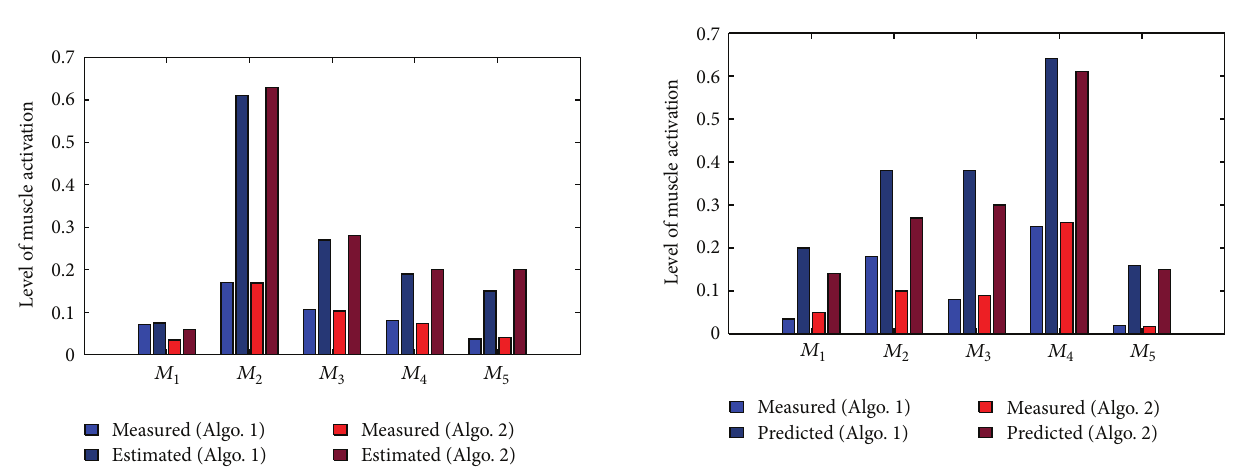
Figure 12: Level of muscle activation (Target: 𝑀 1 ).